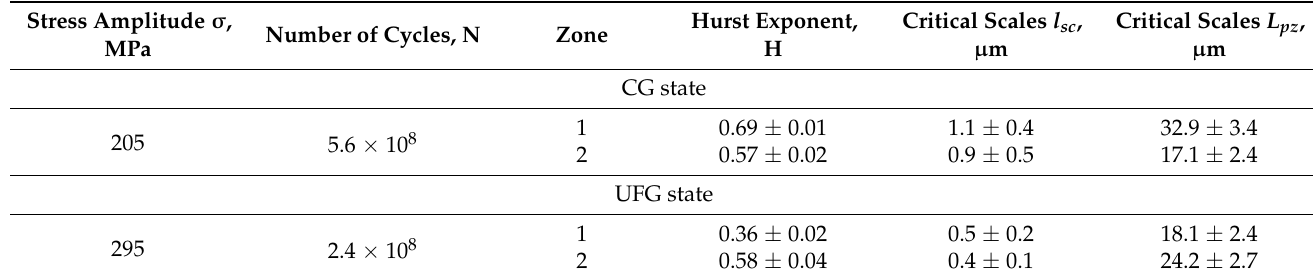
Hurst Exponent, H